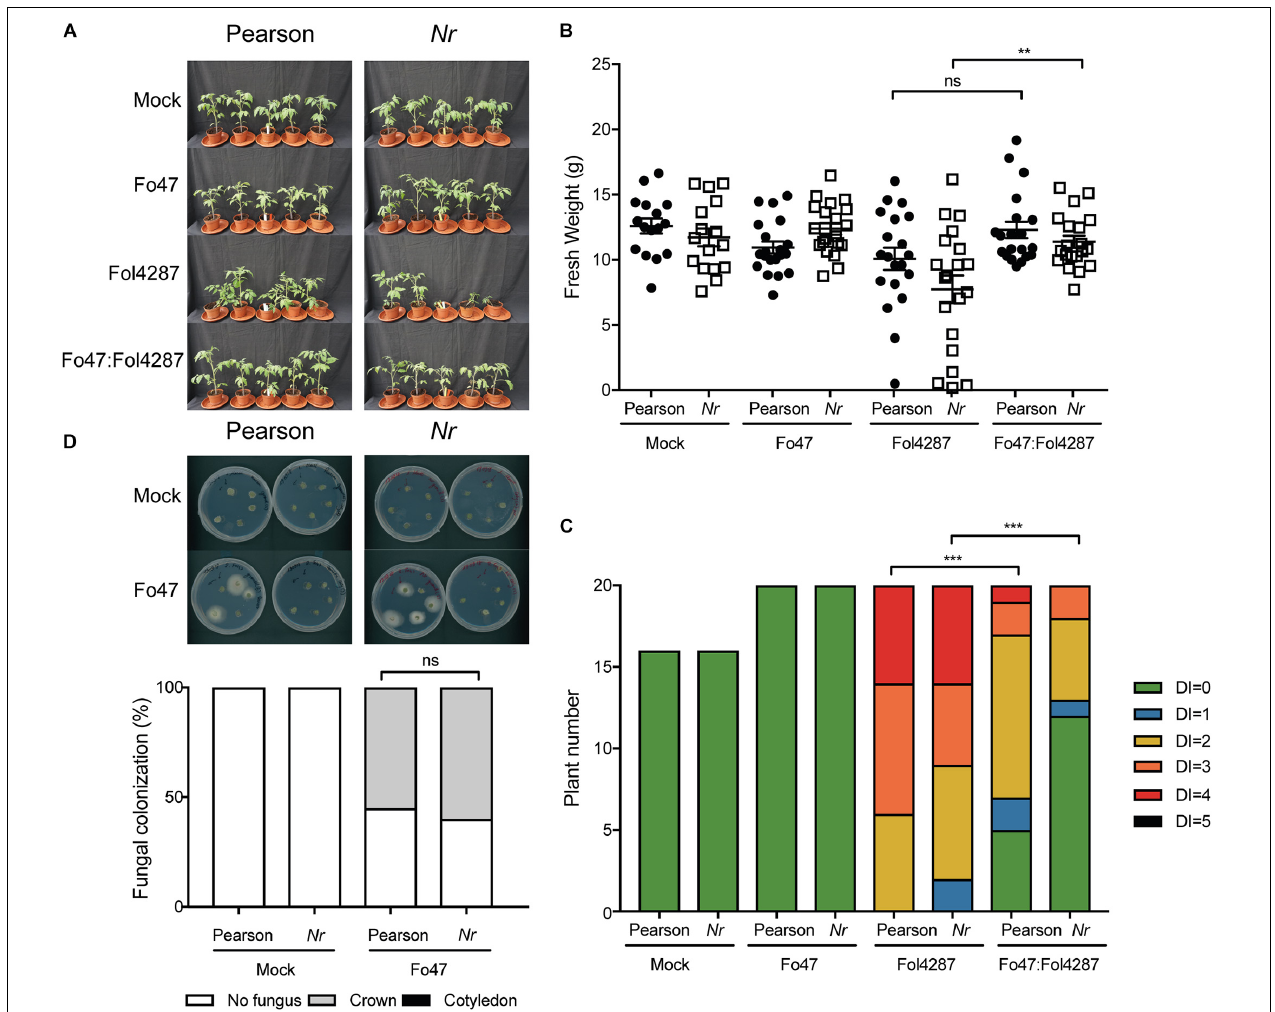
FIGURE 4 | EMR is not affected in tomato plants impaired in to ethylene production. (A) Ten days old tomato seedlings (UC82B) and ACD plants impaired in ET production were inoculated with water (mock), Fo47, Fol4287 or co-inoculated with Fo47 and Fol4287. Disease development was assessed by measuring fresh weight (B) and disease index (C) 3 weeks after inoculation. Raw data was analyzed by a non-parametric Mann–Whitney U -test ( ns P > 0.05, ∗∗ P < 0.01, ∗∗∗ P < 0.001). The bioassay was performed two times with similar results ( n = 10 for the first repetition and n = 20 for the second). (D) Representative stem pieces taken from crown (left) and cotyledon (right) level of five individual plants incubated for 4 days on PDA plates. Percentage of Fo47 colonization on mock-inoculated plants ( n = 10) and Fo47 treated plants ( n = 20). The experiment was performed two times with similar results. Raw data was analyzed by a non-parametric Mann–Whitney U -test ( ns P >